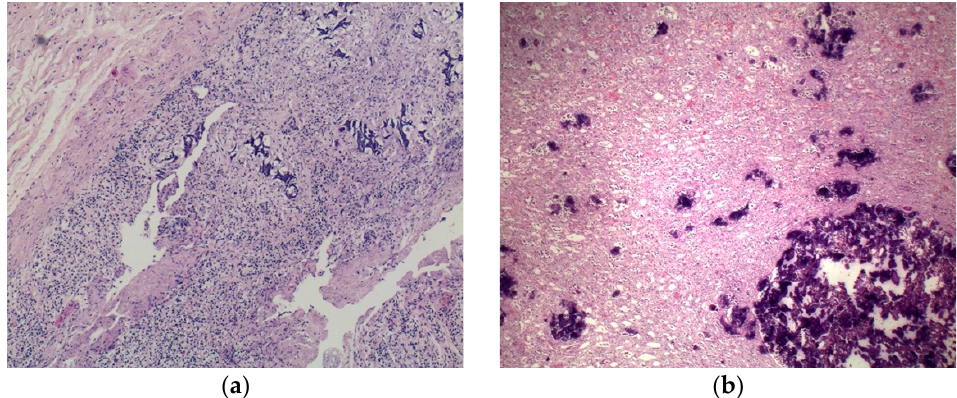
Figure 6. Metastatic calcification involving viscera—calcium is recognisable in routine sections due to its affinity for haematoxylin. ( a ) Stomach, H&E staining—magnification 60×. Granular depositions of amorphous calcium salts in the lamina propria of the gastric mucosa. ( b ) Kidney, H&E staining—magnification 60×. Granular depositions of amorphous calcium salts in the kidney medullar interstitium.